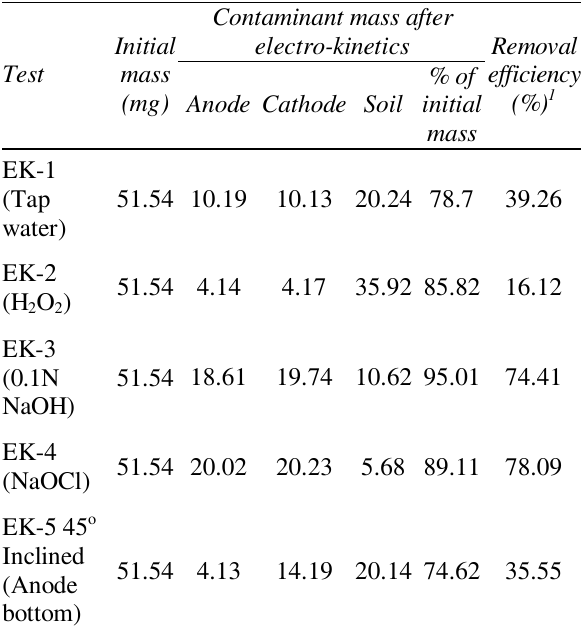
Table 2 : Arsenic Mass Balance and Removal